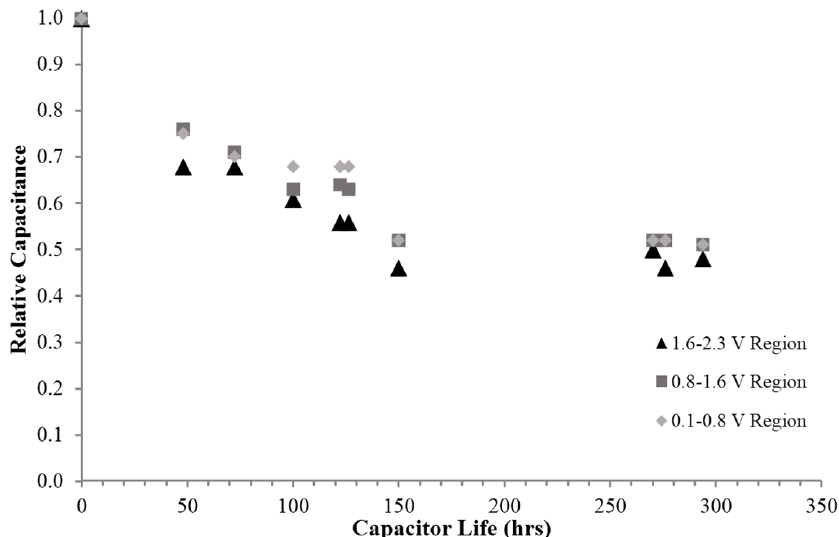
Figure 8. Relative capacitance as a function of time. As shown the capacitance decreases steadily for the first 150 h, and then stabilizes. All three capacitive regions, 0.8–0.1 V, 1.6–0.8 V, and 2.3–1.6 V loose capacitance at roughly the same rate.